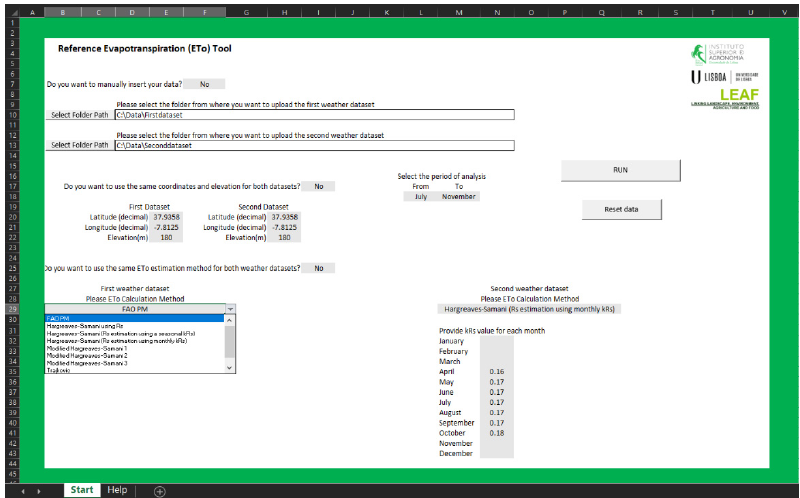
Figure 2. ETo Tool interface: input data and ETo estimation method selection.